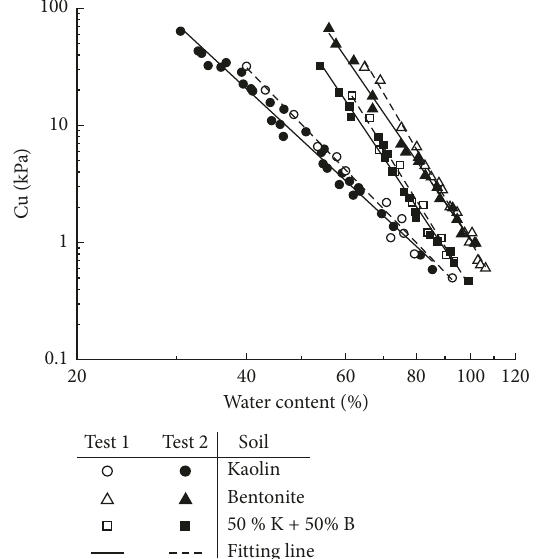
Figure 4: Undrained shear